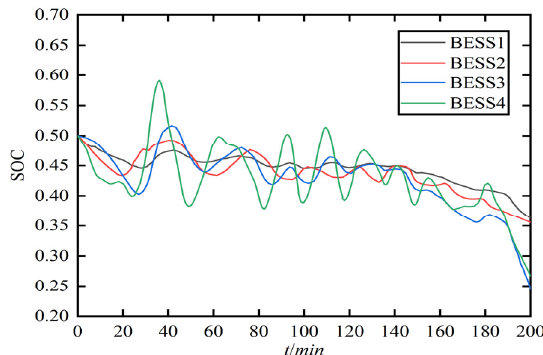
Figure 18. SOC of the DBESS based on power ratio.